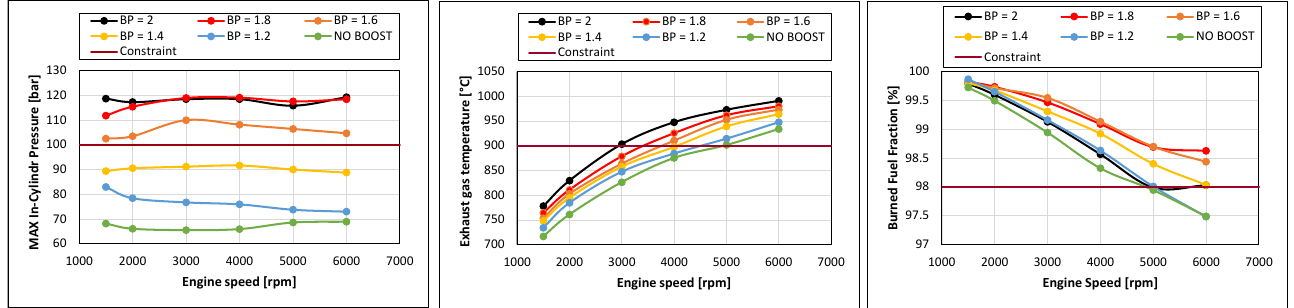
Figure 8. Maximum in-cylinder pressure ( left ), exhaust gas temperature ( middle ) and burned fuel fraction ( right ) calculated for the engine running at the maximum torque knock limited spark ad- vance.